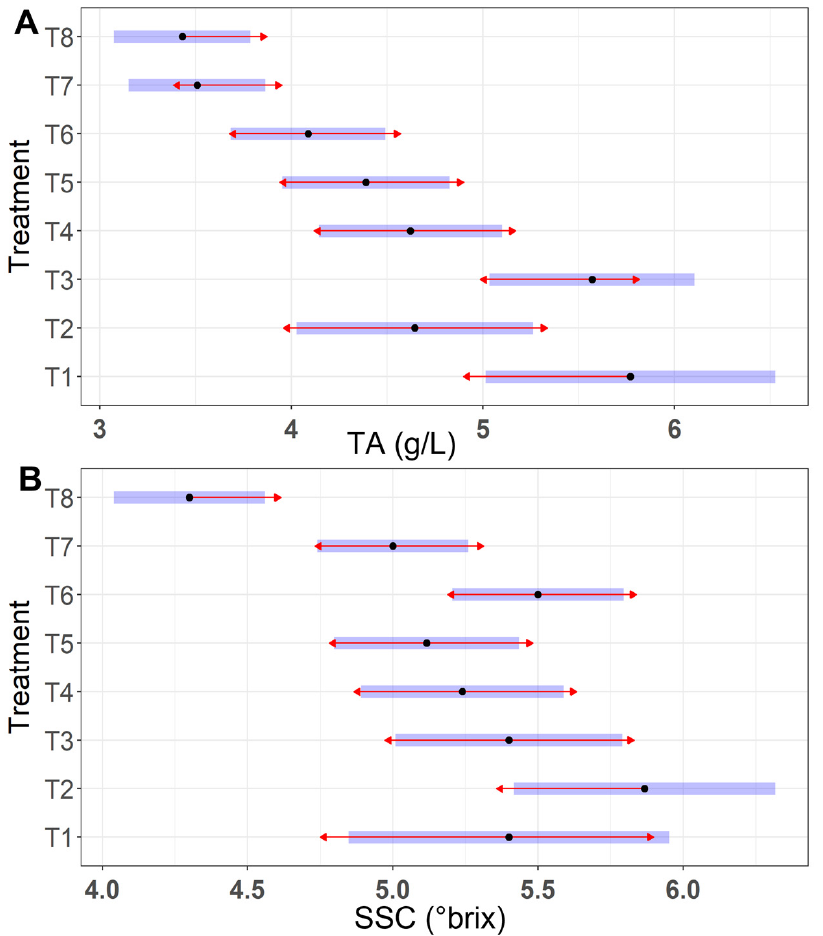
Figure 6. Average values of fruit TA ( A ) and SSC ( B ) across seven treatment rates of UWP (T1 = 0.3%; T2 = 0.5%; T3 = 0.8%; T4 = 1%; T5 = 2%; T6 = 3%; T7 = 5%), and Hoagland’s solution (T8). Dots indicate averages of fruit pooled together across the ten replicate pots in each treatment. Bars denote the confidence limit. When the red arrows overlap among treatments, then the treatments are not significantly different.